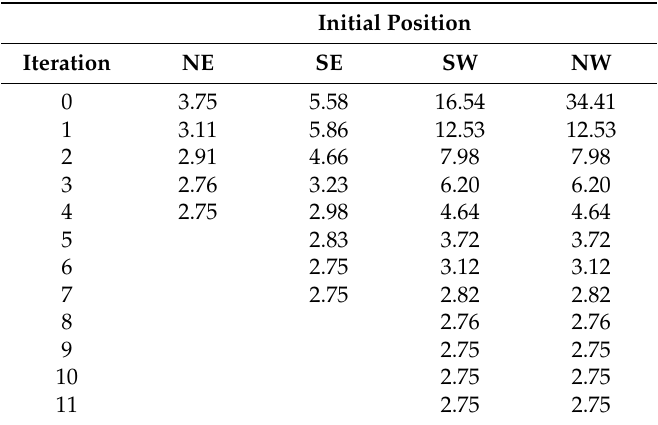
Table 1. Function values at